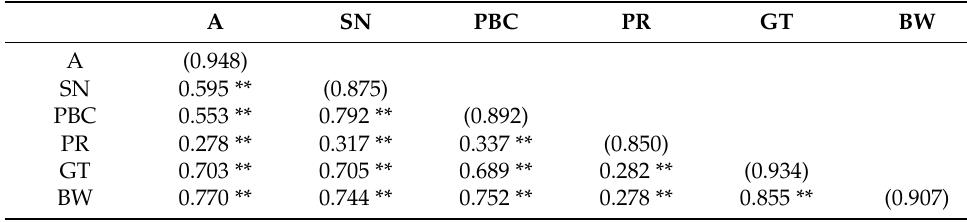
Table 8. Correlation matrix and discriminant validity for the